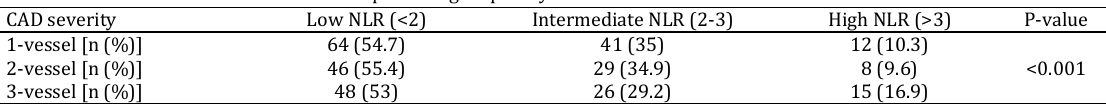
Table 3. Procedural characteristics of the patients grouped by NLR CAD